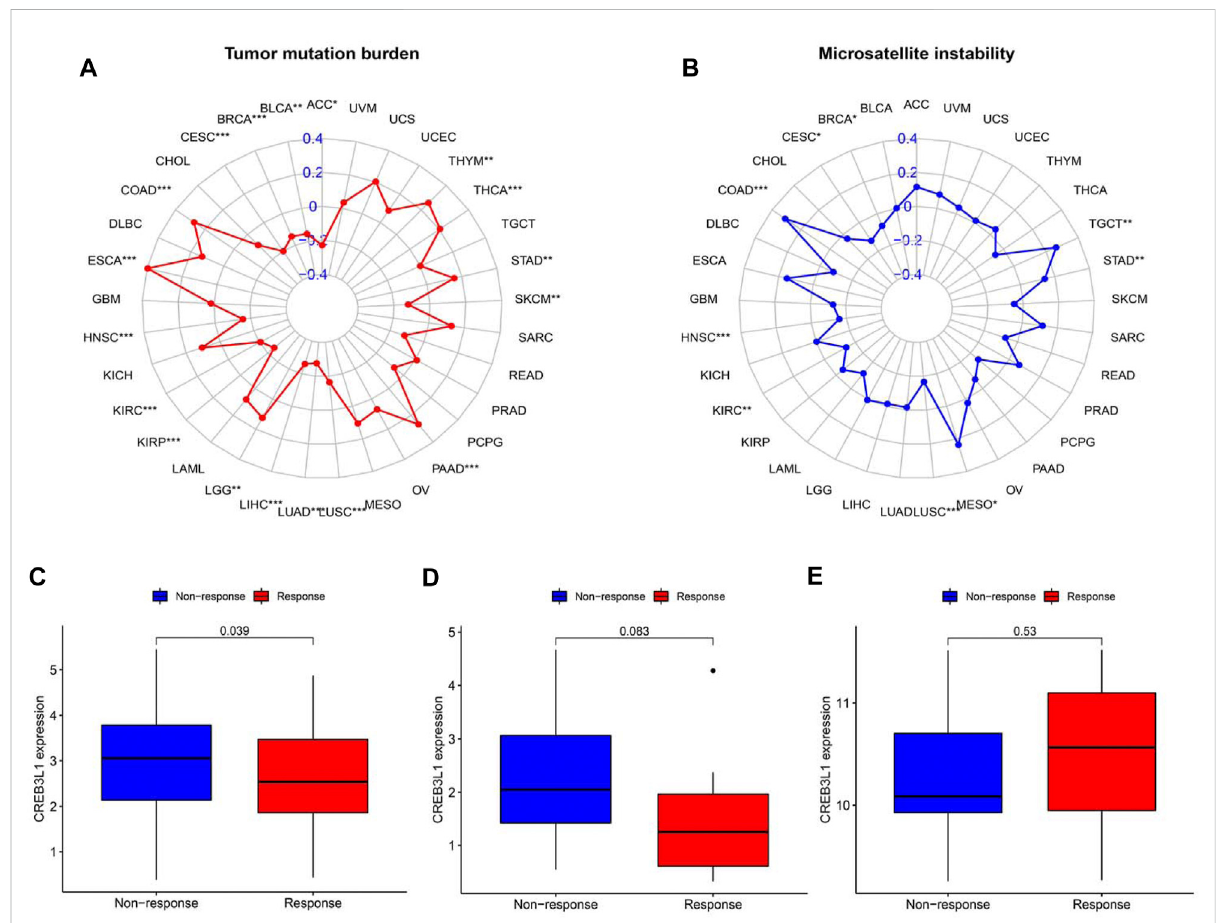
FIGURE 9 ThecorrelationbetweenCREB3L1 expressionandTMBlevels,MSIeventandtheimmunotherapeuticef fi cacy. (A) Radarmapoftherelationship between CREB3L1 expressionand TMB levels. (B) Radar map of the relationship betweenCREB3L1 expression and MSI event. (C – E) The relationship between CREB3L1 expressionand theimmunotherapeuticef fi cacy in IMvigor210 cohort (C) , GSE78220 (D) , and GSE67501 (E) . * p < 0.05, ** p < 0.01; *** p <